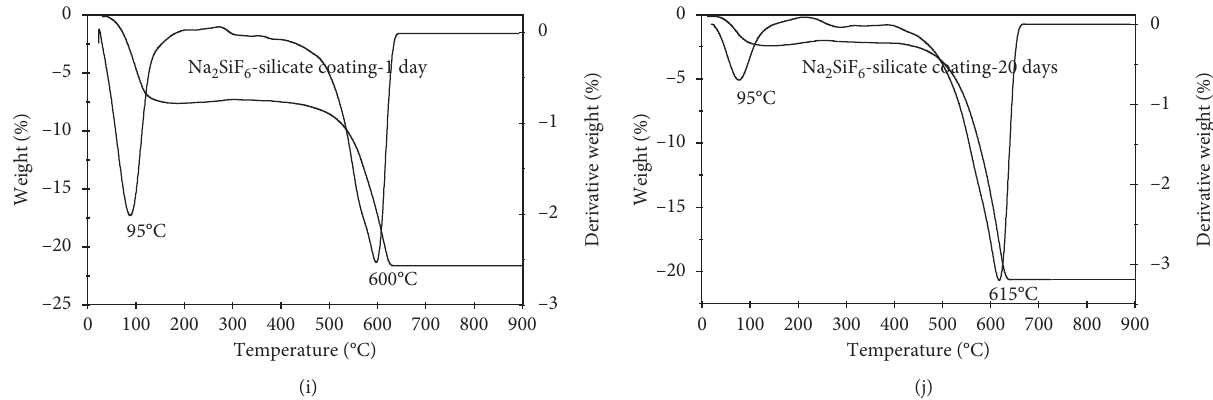
Figure 3: TGA and DTG curves of the stable mixing of ZnO-silicate coating at 1 day (a); ZnO-silicate coating at 20 days (b); TiO coating at 1 day (c); TiO 2 -silicate coating at 20 days of curing (d); Fe 2 O 3 -silicate coating at 1 day (e); Fe 2 O 3 -silicate coating at 20 days (f); CaCO 3 -silicate coating at 1 day (g); CaCO 3 -silicate coating at 20 days (h); Na 2 SiF 6 -silicate coating at 1 day (i); Na 2 SiF 6 -silicate coating at 20 days of curing